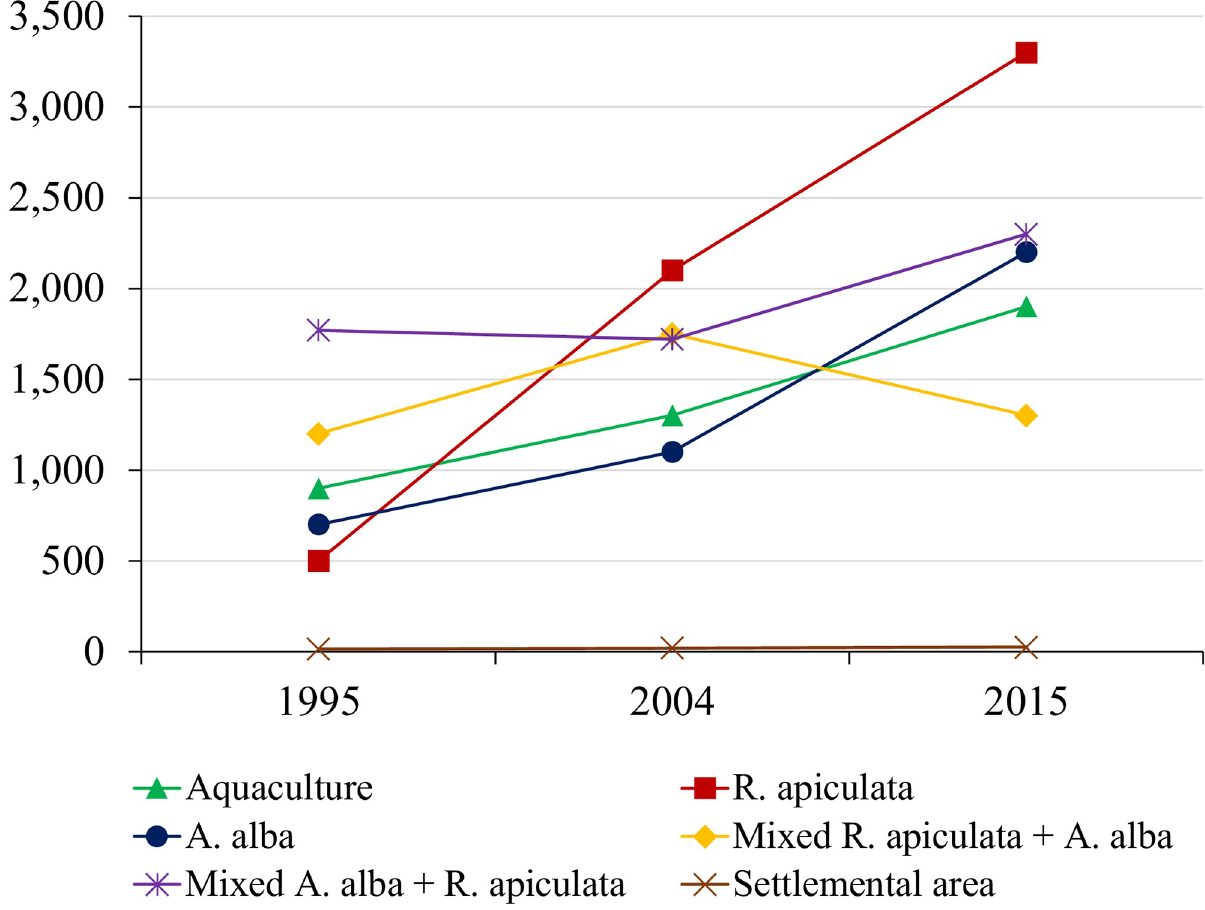
Fig 10. Change of mangrove areas in Ca Mau from 1995 to 2015.